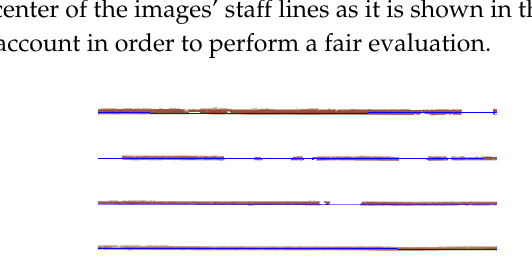
Figure 9. Example of staff line ground truth data drawn on the original image. Sample